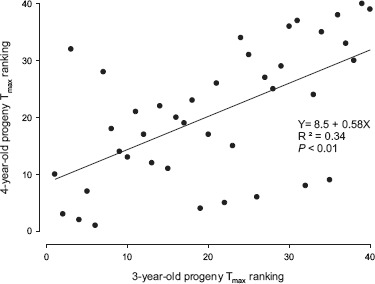
Regression of Tmax rank in 4-year-old F2 seedlings (n = 50) on a similar ranking for the same group of 3-year-old progenies. Lower numbers have higher cold hardiness.